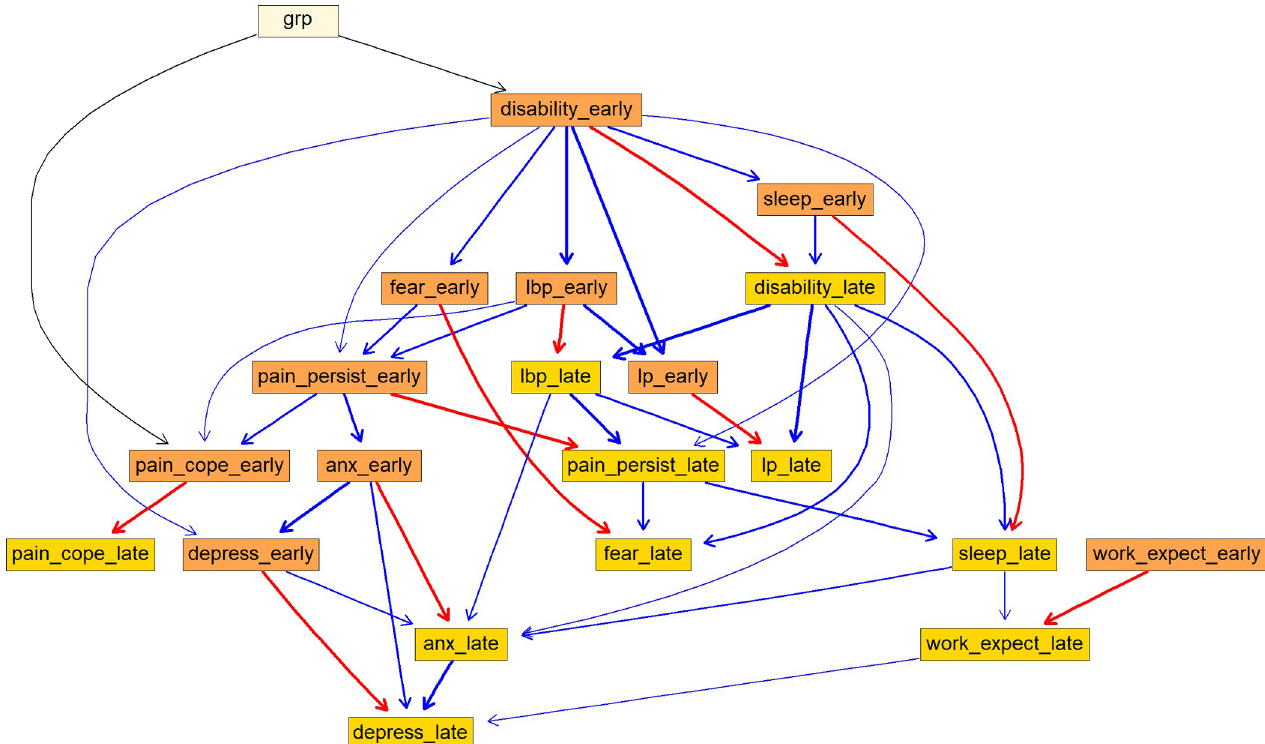
Fig 2. The directed acyclic graph (DAG) underlying the consensus Bayesian Network learned from the variables across 289 participants. The colour of the arcs reflect the sign (positive [blue] or negative [red]) of the β coefficient value relating the “parent” to “child” variables. The thickness of the arcs reflects the proportion of times each arc was found in the 200 Bayesian Network models built; only arcs that appeared in > 50% of the networks are included in the final averaged consensus network. Abbreviation: Suffix with “_early”–change score between baseline and week-10 follow-up; “_late”–change value between week-10 and week-52; Anx—anxiety; lbp–low back pain; lp–leg pain; IndvPT–individualised physiotherapy.